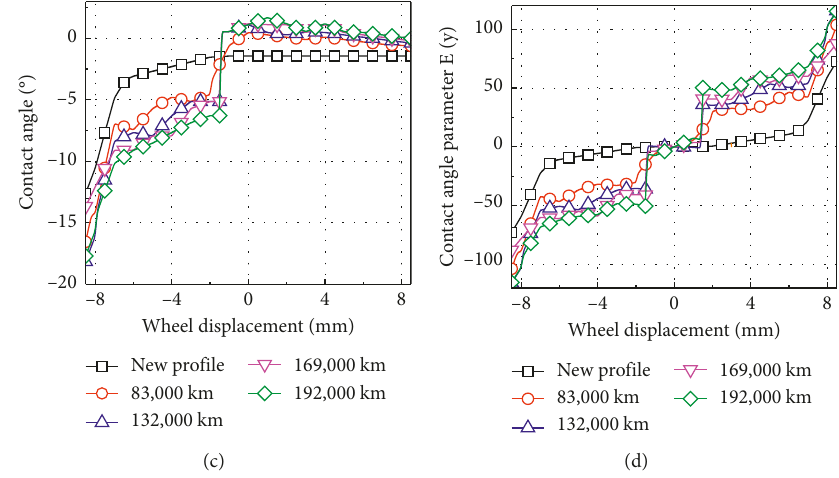
Figure 12: Wheel-rail rolling contact parameters: (a) Rolling circle radius difference; (b) equivalent conicity; (c) contact angle; (d) contact angle